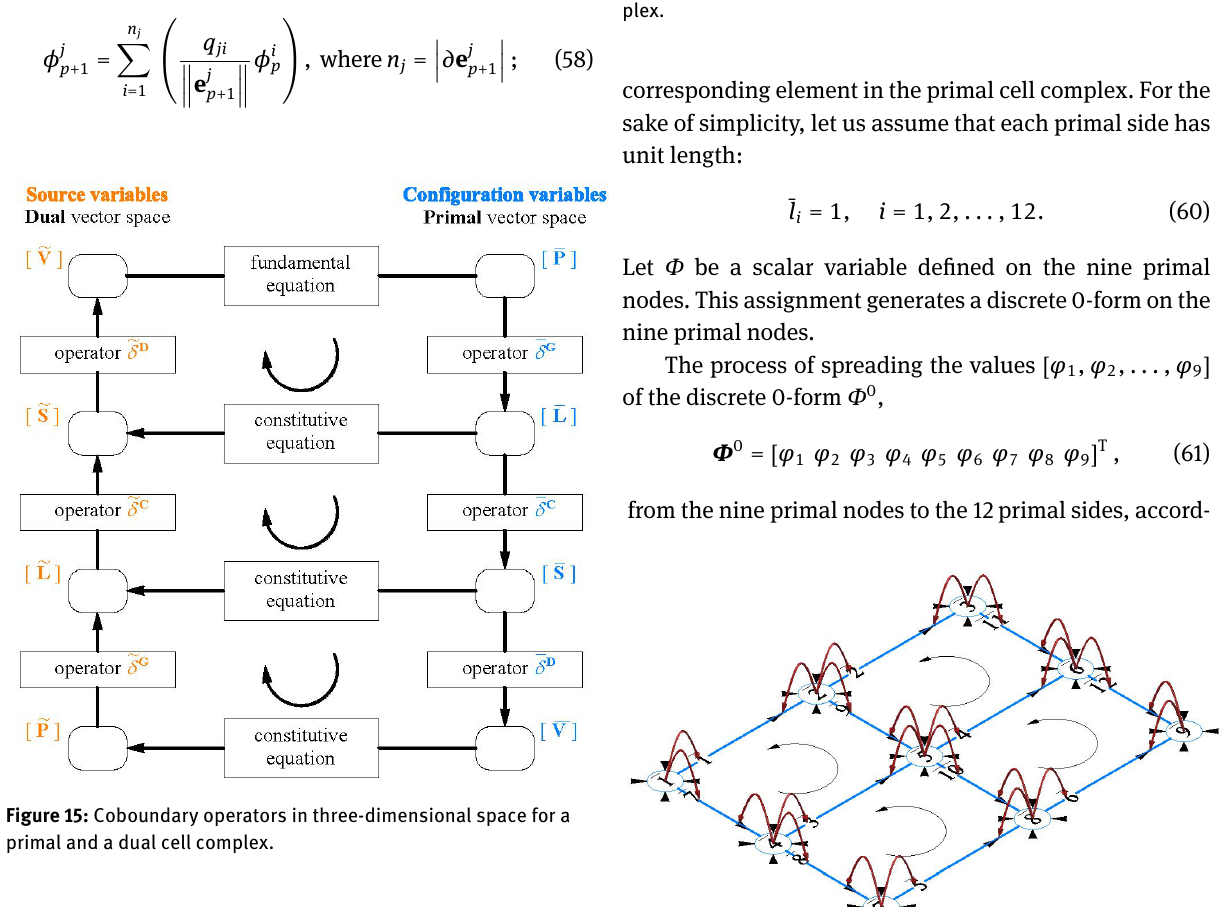
Figure 16: An example of plane primal complex and its dual com- plex.